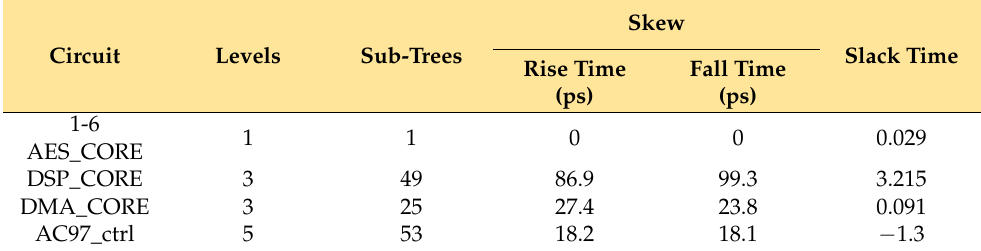
Table 5. Skew results after CTS using our proposed methodology.